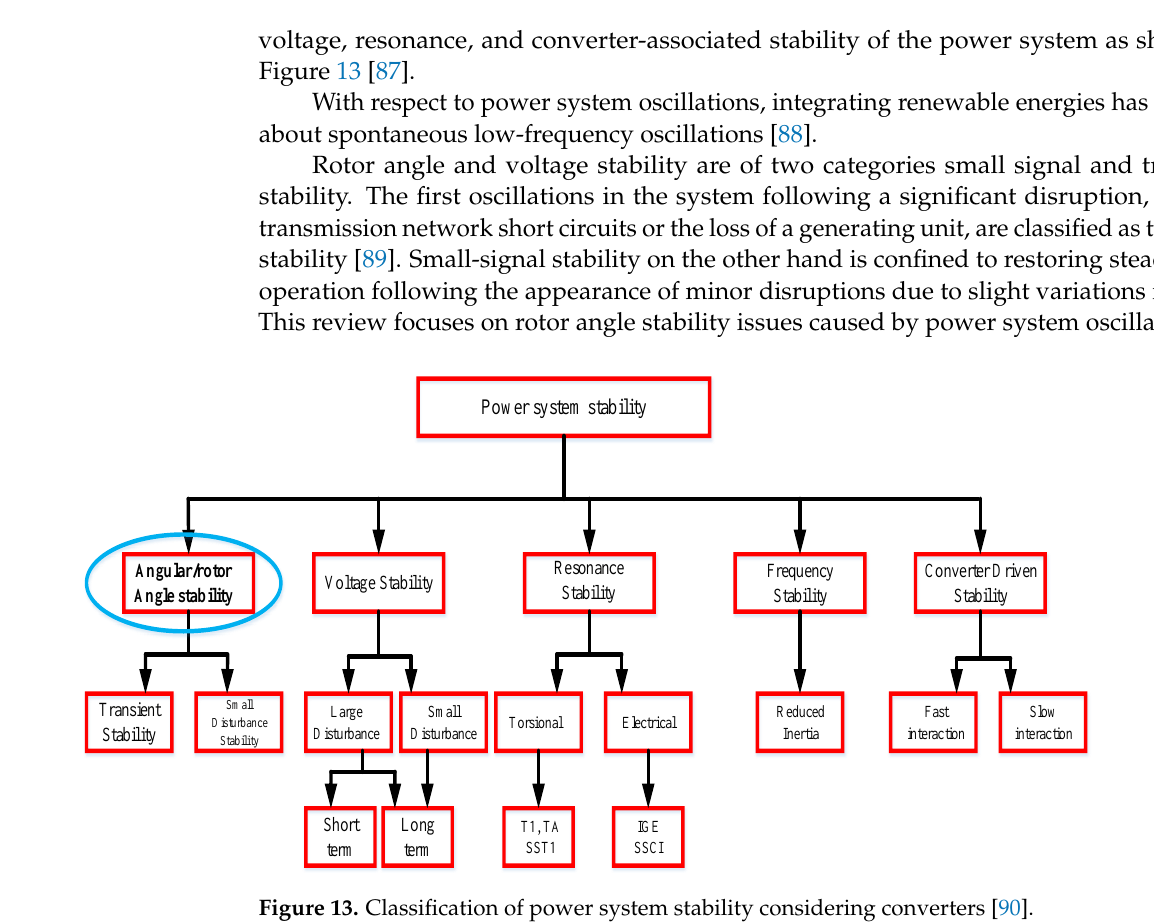
Figure 13. Classification of power system stability considering converters [91].